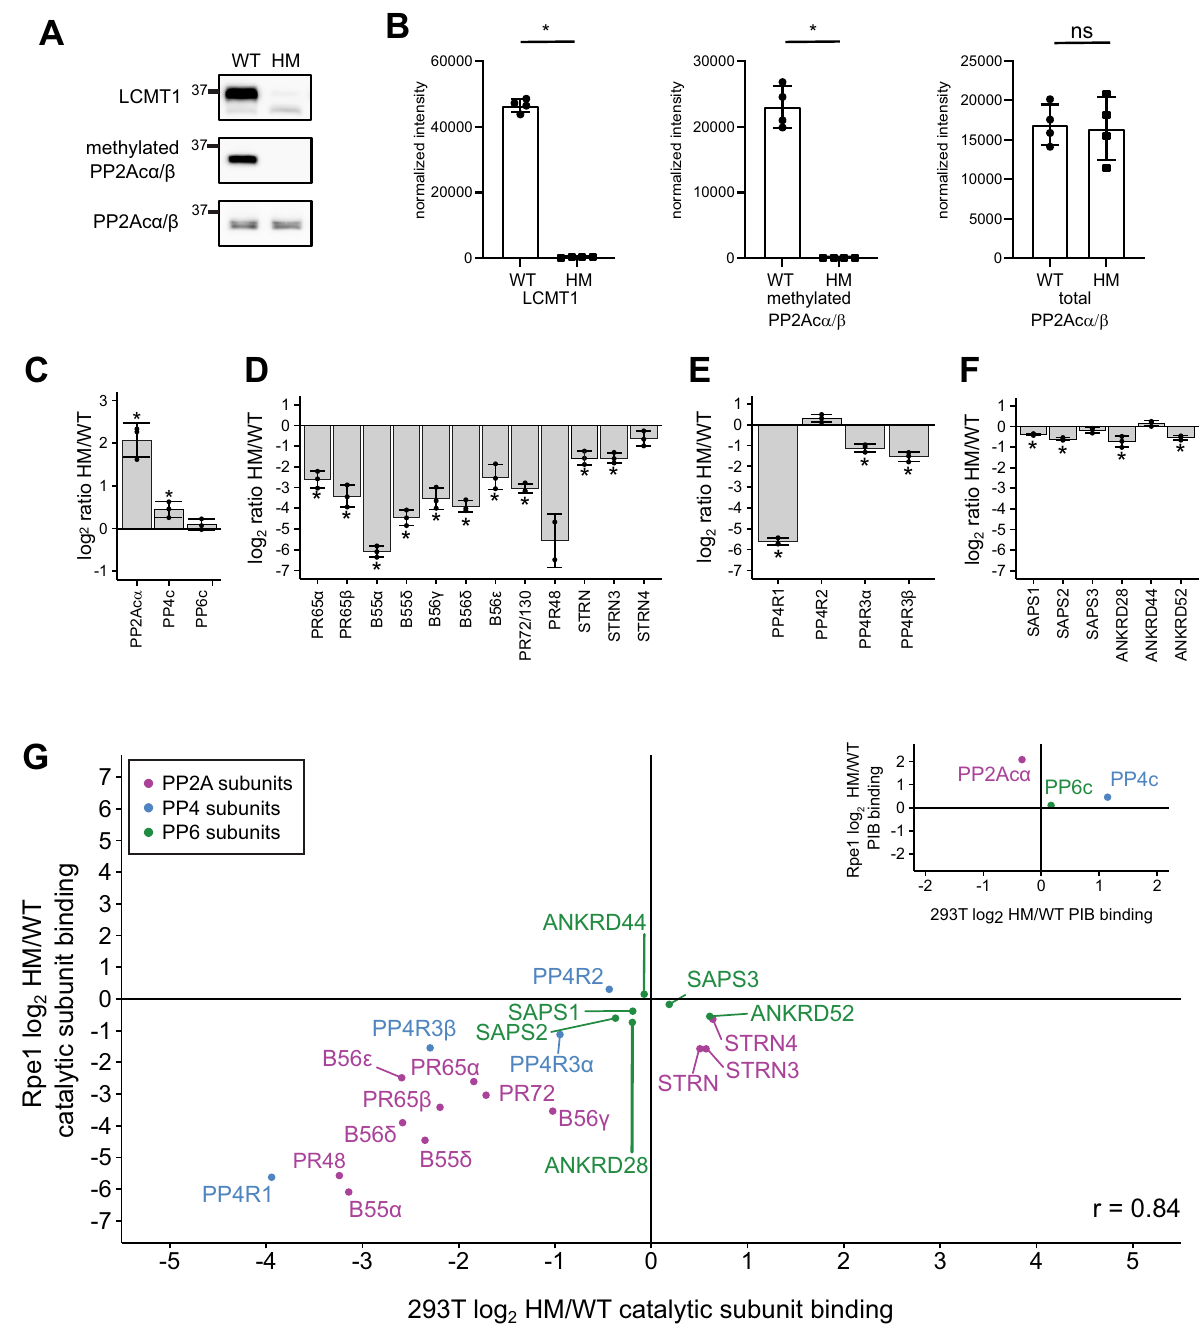
293T log HM/WT catalytic subunit binding 2 Figure 6. The effects of disrupting LCMT1 expression in Rpe1 cells on the holoenzyme composition of PP2A, PP4, and PP6. ( A ) Western blots of wild-type (WT) and hypomorph (HM) Rpe1 cells probed for LCMT1, methylated PP2Acα/β, and total PP2Acα/β ( B ) Western blots were quantified and correct for loading based on total protein, and individual data points are shown for LCMT1, methylated PP2Acα/β, and total PP2Acα/β. Error bars represent the standard deviation of four replicates. The log 2 HM/WT ratio of the abundance of the catalytic subunits ( C ), PP2A subunits ( D ), PP4 subunits ( E ), and PP6 subunits ( F ) bound to the PIBs as determined by proteomics analysis. ( G ) Scatterplot of the log 2 HM/WT ratio of PP2A, PP4, and PP6 subunits binding to PIBs and normalized to the respective catalytic subunit from HEK293T cells versus Rpe1 cells. PP2A subunits are labeled in purple, PP4 subunits are in blue, and PP6 subunits are in green. The scatterplot in the upper right depicts catalytic subunit PIB binding HEK293T cells versus Rpe1 cells. * p <